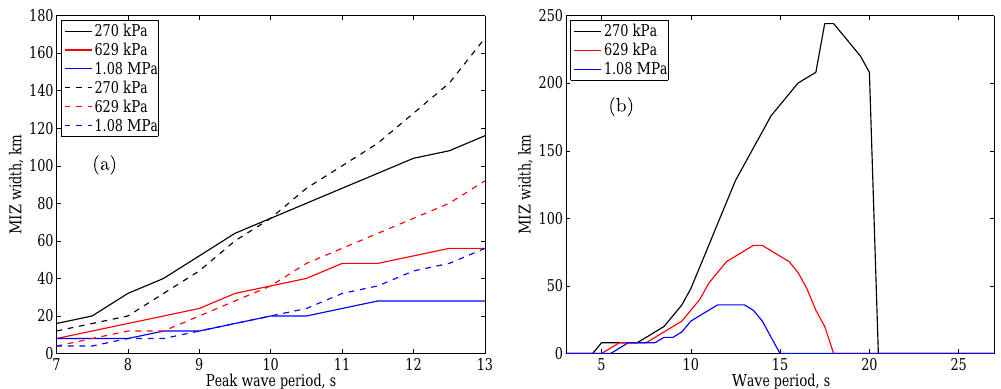
Figure 6. Variation of MIZ width with peak wave period and small-scale cohesion for (a) wind seas and (b) swells. (a) Dashed curves: Pierson–Moskowitz spectra are used for the forcing. Solid curves: Bretschneider spectrum are used with the significant wave height being 4m. (b) Swell waves of height 3m. For both plots, the concentration is 0.7, the thickness is 1m, and the Young’s modulus used was 5.49GPa. The WIM is not coupled to